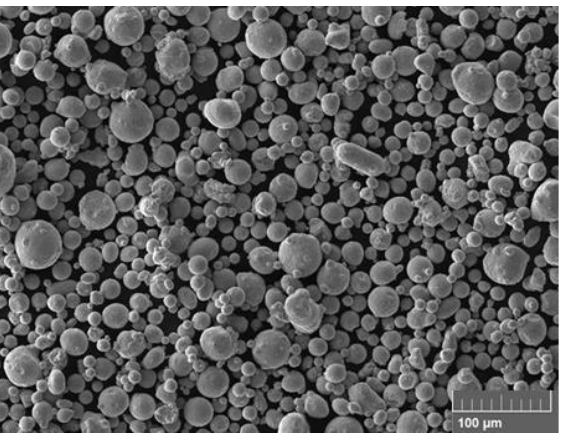
Figure 1. SEM (Scanning Electron Microscope) image of the material investigated.